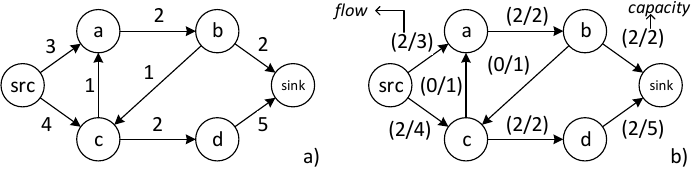
Figure 16. A simple flow network, a) , and its maximum flow, b)